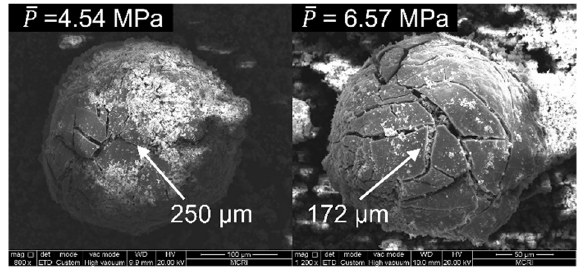
Figure 10. SEM images of agglomerations.